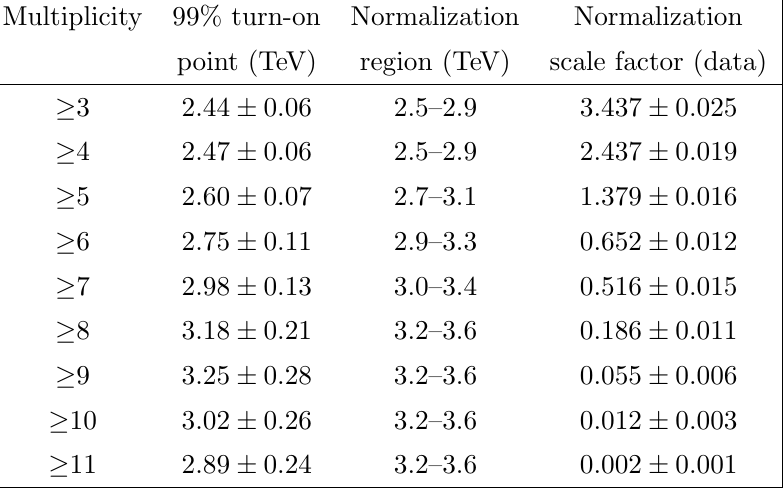
Table 3 . The S T invariance thresholds from (cid:12)ts to simulated QCD multijet background spec- tra, normalization region de(cid:12)nitions, and normalization scale factors in data for di(cid:11)erent inclusive